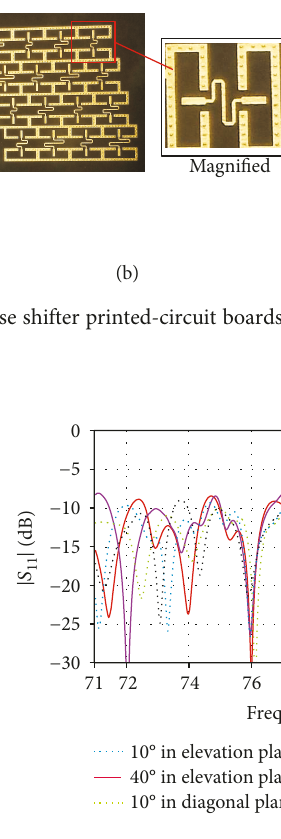
Figure 14: Measured re fl ection coe ffi cient for di ff erent beam- steering